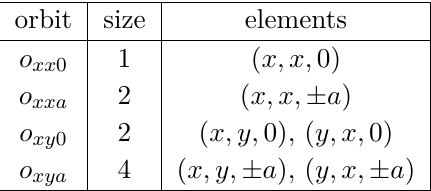
Table 6. Orbit types for the frame with d ref = ( n, n, 0) , where n 6 = 0 . Notation as in table 4, with integers a, x, y satisfying a > 0 and y > x .